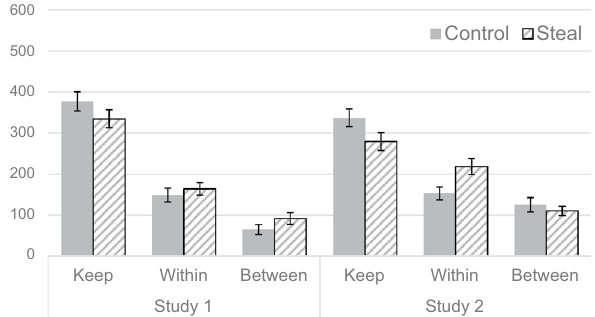
Figure 2. Mean estimated keep or invest amounts by other in-group members in each condition (error bars represent standard errors).